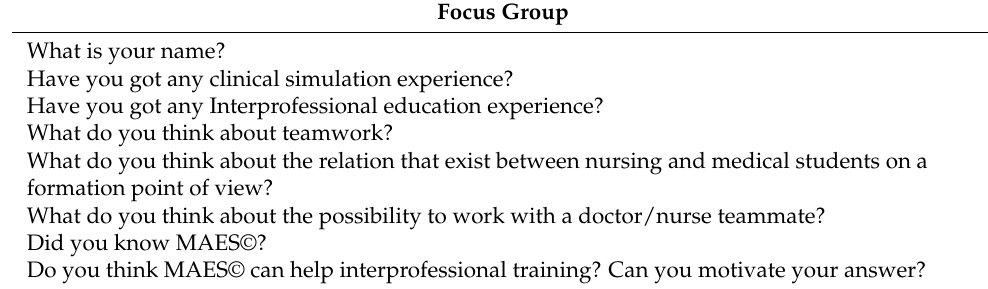
Table A4. Focus Group.